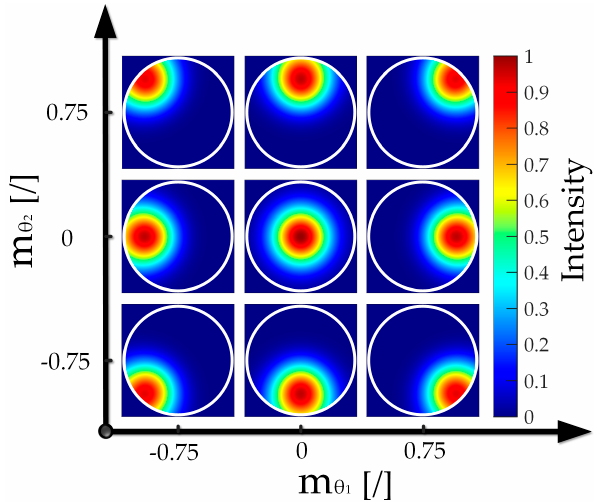
the axis of the tilted return beam of any dimension is defined at the focal point of the diaphragmatic plane. Thus, the ratio m θ of the distance f tan 2 θ from the intersection of the diaphragm plane to the incident optical axis and the radius R of the diaphragm is defined as the relative inclination angle [27], where f indicates the focal length of the microscope’s objective and θ represents the tilt angle.